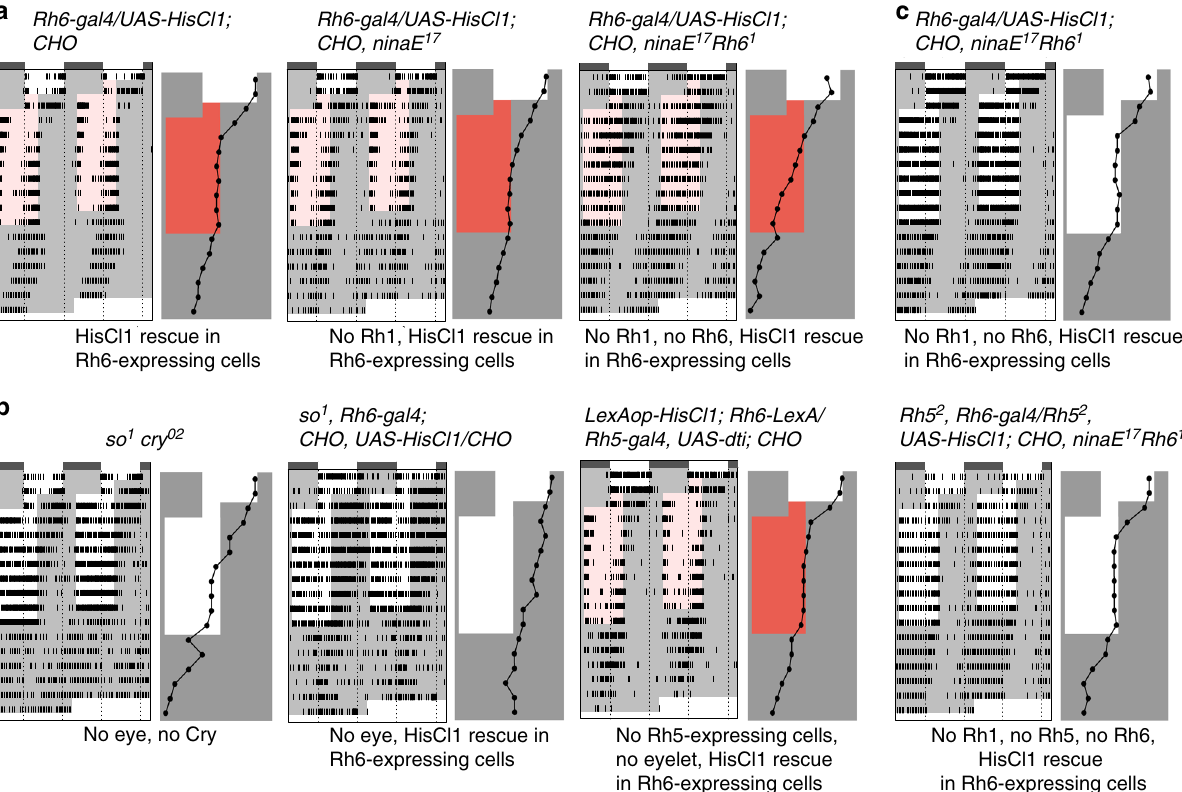
Fig. 5 HisCl1 in Rh6-expressing photoreceptors receive inputs both from outer and inner photoreceptors. a – c Actograms and phase plots. The experimental design is as described in Fig. 1 legend. a The RD phase advance rescue of CHO fl ies by HisCl1 expression in Rh6 photoreceptors (left) is slowed down by the absence of Rh1 ( ninaE 17 mutation, center) and is abolished by the absence of both Rh1 and Rh6 ( ninaE 17 Rh6 1 genetic background, right). b Flies lacking Cry, compound eyes, and ocelli but retaining the H-B eyelet synchronize with advanced LD cycles ( so 1 ; cry 02 double mutants, left), but do not if HisCl1 expression is restricted to Rh6 photoreceptors (center). CHO mutants with HisCl1 rescue in Rh6 cells and genetic ablation of the eyelet (in addition to Rh5-expressing photoreceptors) synchronize with advanced RD cycles (right). c The LD phase advance rescue of CHO fl ies by HisCl1 expression in Rh6 photoreceptors is retained in the absence of either Rh1 and Rh6 (top) or Rh1, Rh5, and Rh6